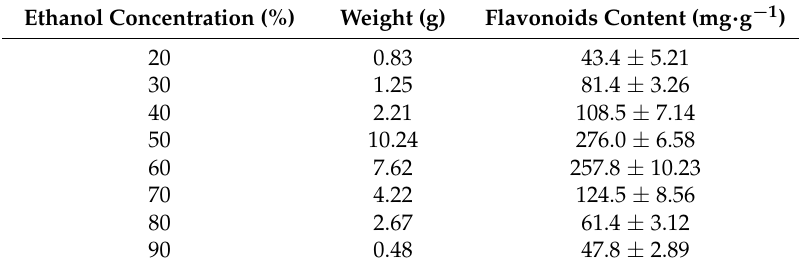
Table 1. Weight and flavonoid contents of different ethanol concentration elution